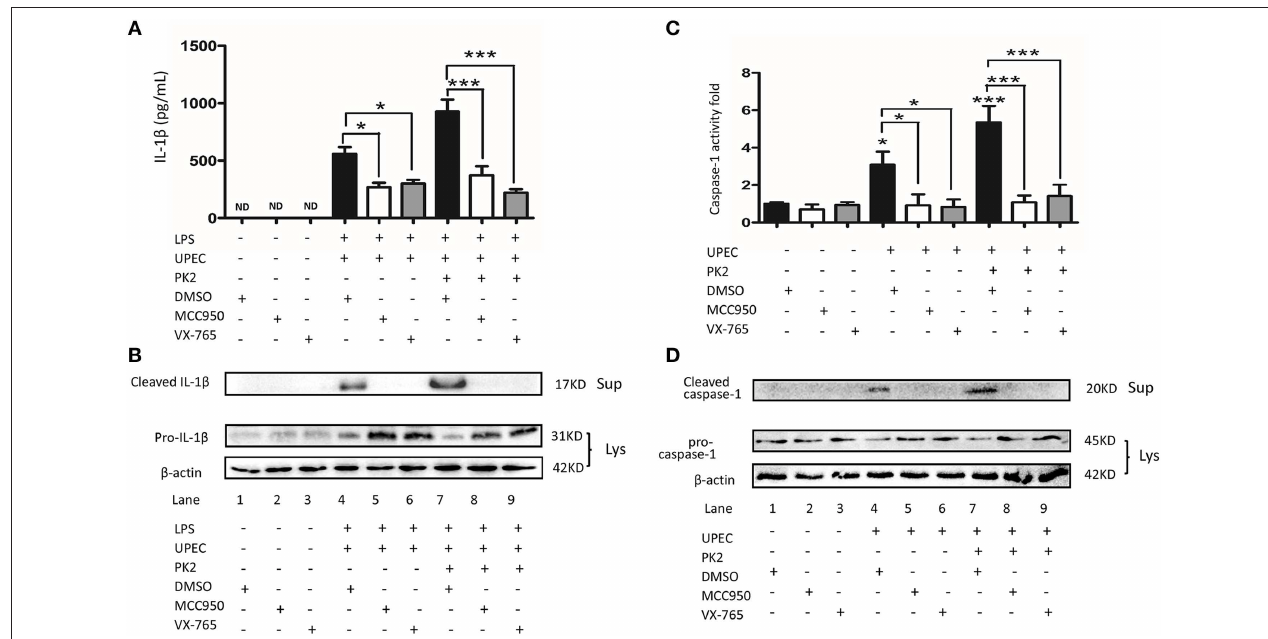
FIGURE 5 | The UPEC-mediated NLRP3 inflammasome activation is suppressed by NLRP3 and caspase-1 inhibition. (A) TM were primed with 1 µ g/mL LPS for 4h or left untreated, pretreated for 1h with the NLRP3 inhibitor (10 µ M) or caspase-1 inhibitor (50 µ M), and subsequently infected with UPEC (MOI = 20) with or without 10nM PK2 for 2h. The supernatants were collected at 2h post-infection and analyzed for IL-1 β release using ELISA. (B) TM were treated as described above, cell lysates as well as the supernatants were analyzed by western blot for IL-1 β , and β -actin. (C) TM were pretreated for 1h with the NLRP3 inhibitor (10 µ M) or caspase-1 inhibitor (50 µ M) and subsequently infected with UPEC (MOI = 20) with or without 10nM PK2 for 2h. Whole-cell lysates were analyzed by caspase-1 activity assay. (D) TM were treated as described above. Whole-cell lysates and concentrated supernatants were analyzed by western blot with antibodies against caspase 1, β -actin. Ctrl, control; LPS, lipopolysaccharide; DMSO, dimethylsulfoxide; ND, no detected; Lys, cell lysates, Sup, supernatants. * P < 0.05, *** P < 0.001 (one-way